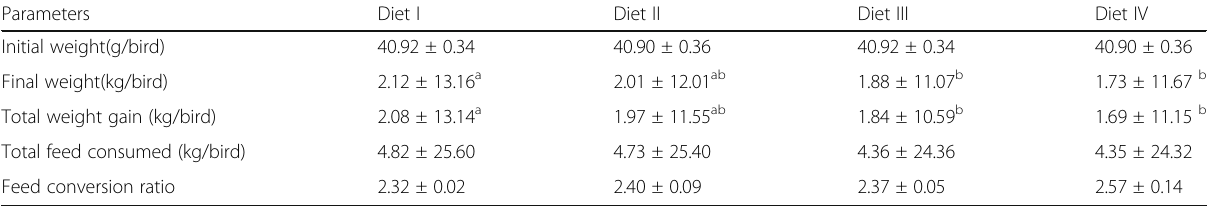
Table 4 Performance characteristics of broiler chickens fed with diets containing fortified bread waste meals Parameters